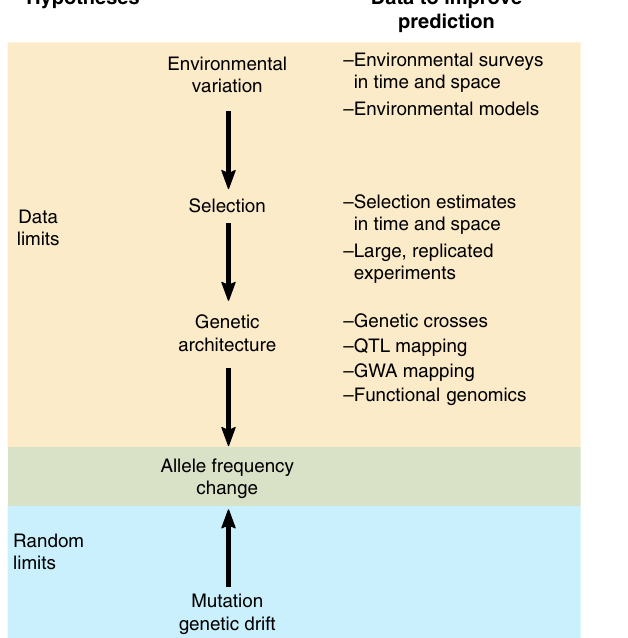
Fig. 2 Schematic illustration of two hypotheses for limitations on predicting evolution. This includes depiction of the evolutionary processes involved, and data which might be used to improve prediction. QTL quantitative trait locus, GWA genome wide